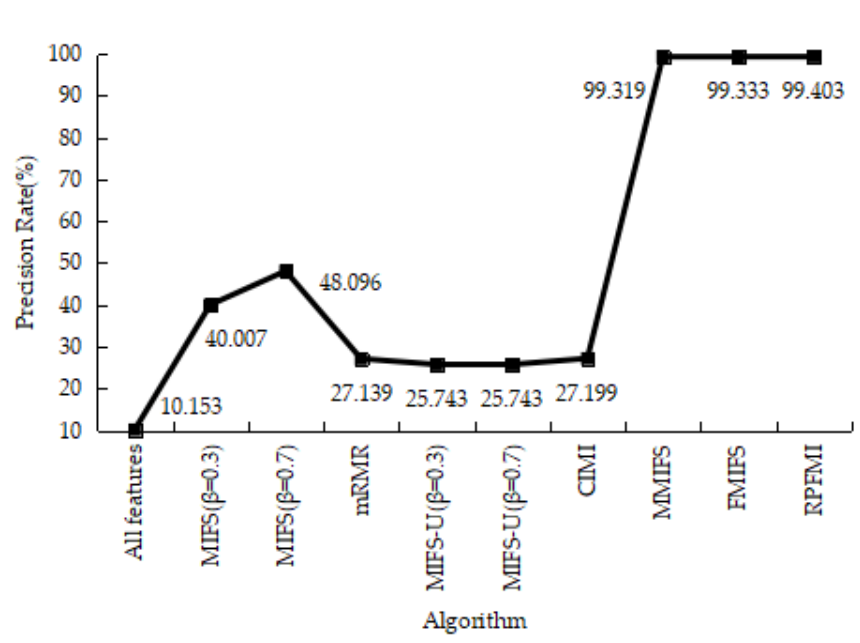
Figure 12. Precision Rate on the R2L test data.